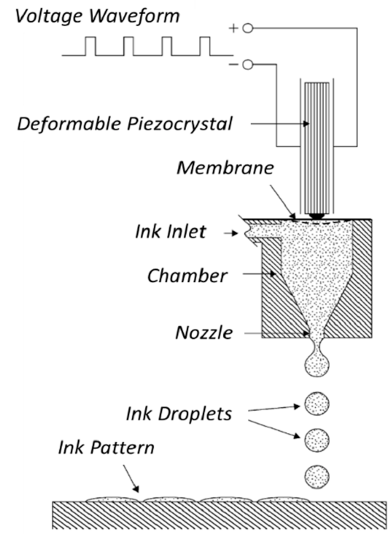
Figure 6. Schematic illustration of piezoelectric inkjet printer. Diagram of the operation of a piezo drop-on-demand (DOD) ink-jet print head. The applied voltage waveform induces the piezocrystal deformation, which generates a pressure wave in the fluid ink inside the microfluidic chamber. The pressure pulse determines the formation of the droplets and their ejection through the nozzle onto the solid support for the pattern formation. Reprinted from Reference [62] , Copyright (2004), with permission from Elsevier.